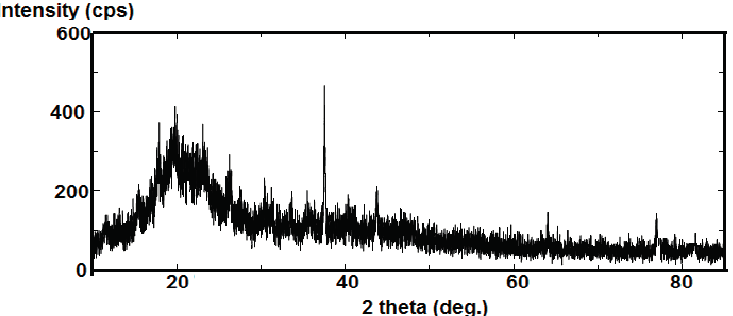
Figure 4. XRD of AA-Na/magnetite composite nanoparticles.